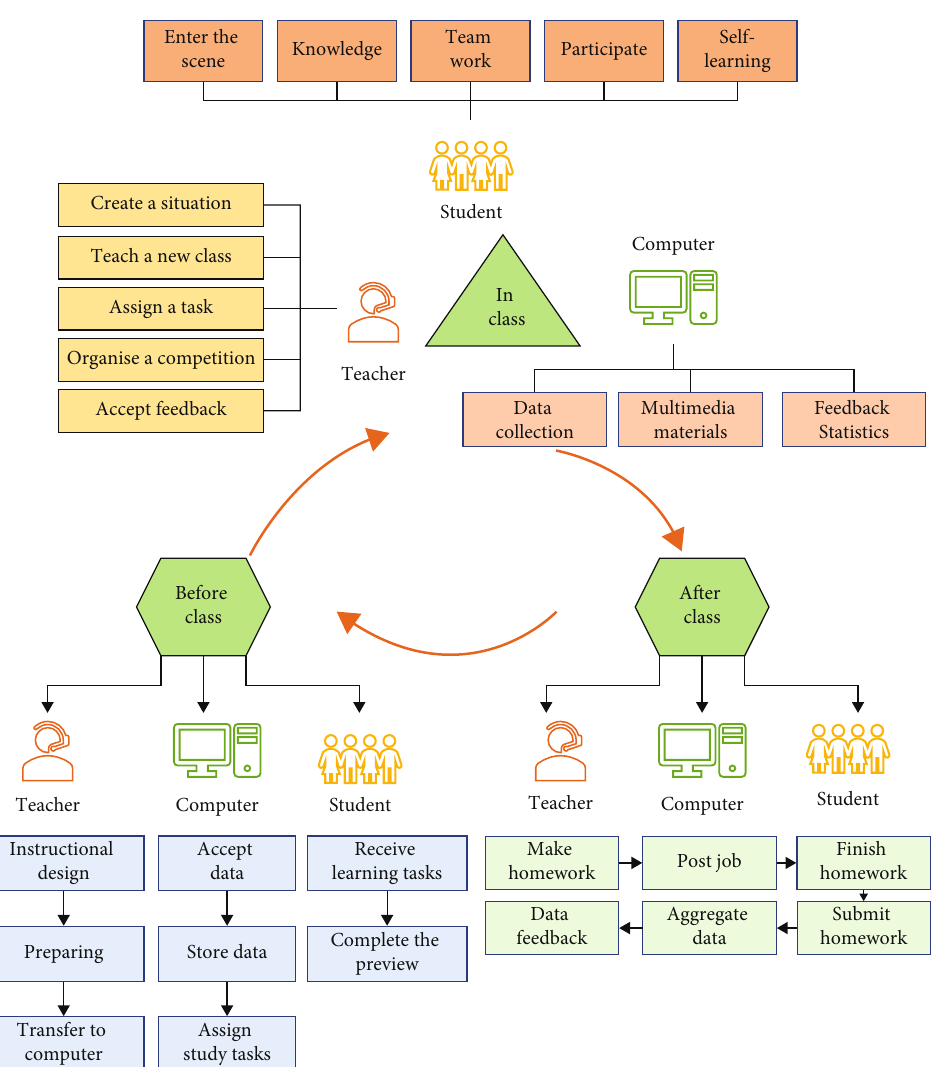
Figure 1: Construction diagram of music classroom teaching mode in primary and secondary